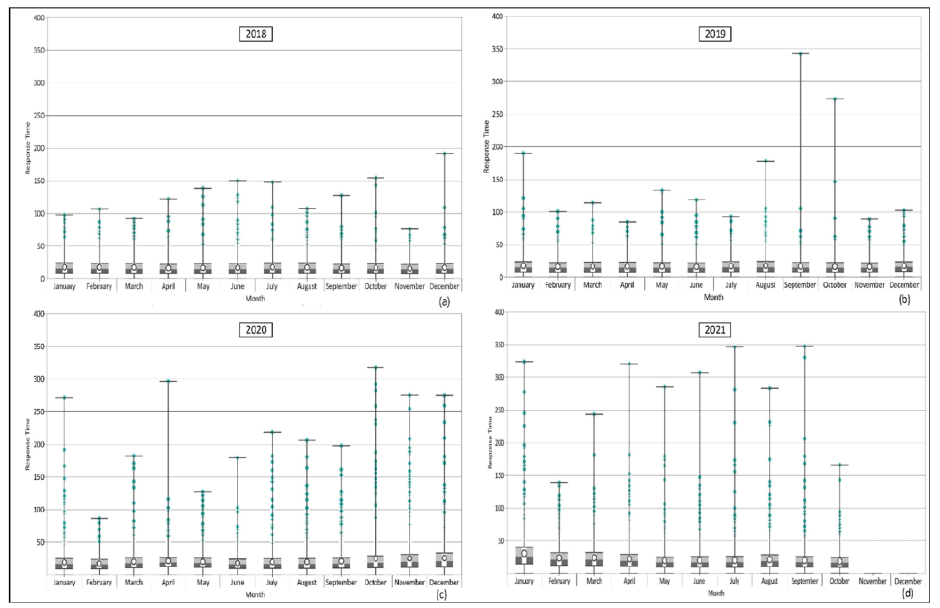
Fig. 7. RT box and plot: 2018-2021 – All Emergency Missions: (a) 2018; (b) 2019; (c) 2020; (d) 2021 Among the emergency COVID-19 related missions, this RT variation is more evident in 2020, at the early stages of the pandemic (Fig. 8).